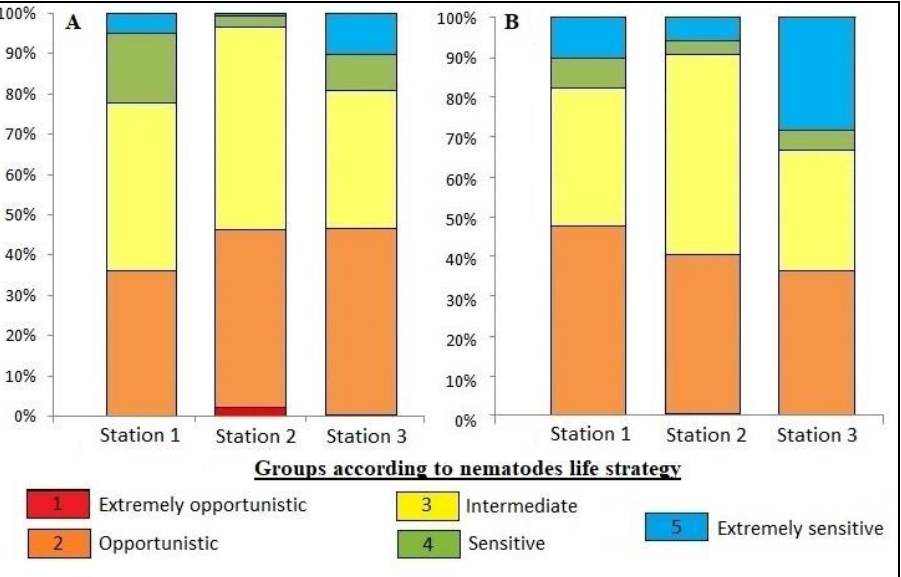
Figure 5. Relative density ( A ) and relative biomass ( B ) of groups according to nematodes life strategy (values from 1 for extremely opportunistic nematode to 5 for extremely sensitive nematode).